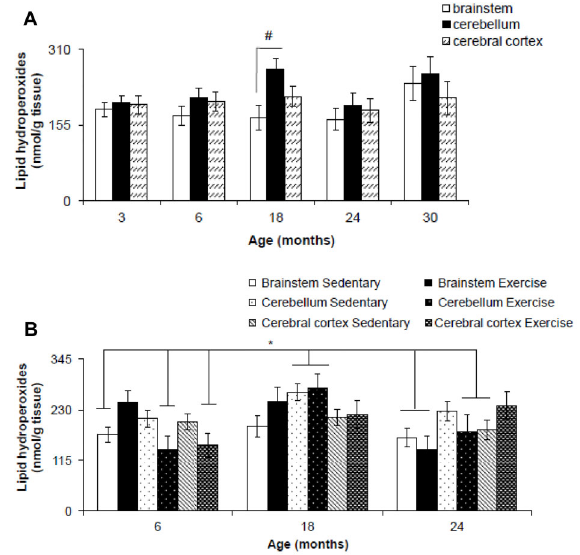
Figure 2. Lipid hydroperoxide levels in the brainstem, cerebellum, and cerebral cortex of Wistar rats of different ages ( A ) and after 12 weeks of treadmill running ( B ). Data are reported as means ± SE. # P o 0.05, two-way ANOVA; *P o 0.05, three-way